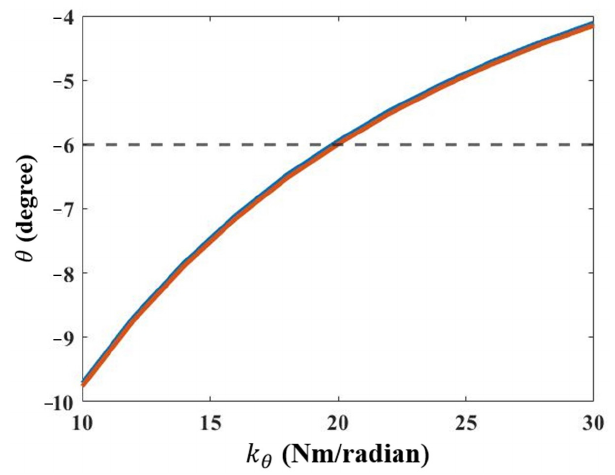
Figure 6. Maximum torsional spring pitching angle vs. torsional spring rigidity. (Solid blue: Pre- morphing (0% span extension), Solid red: Post-morphing (25% span extension), Dashed black: Cutoff value of pitch angle).